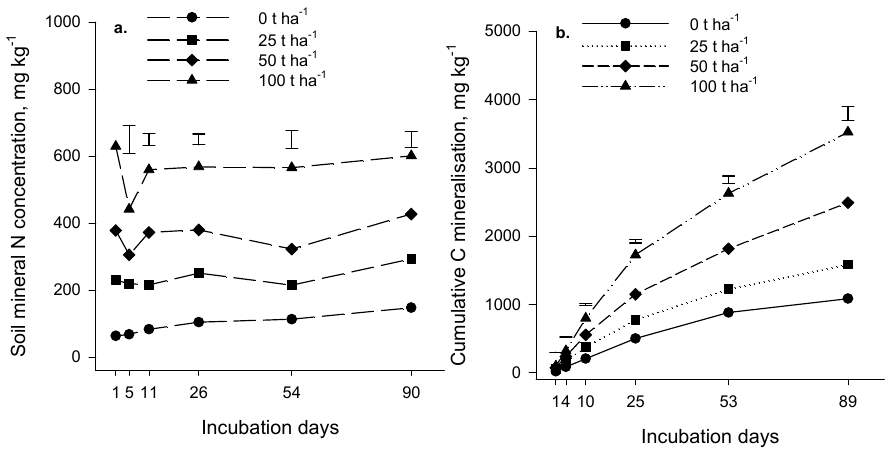
Figure 1. Forage trial incubation: (a) soil mineral N concentration and (b) cumulative carbon mineralization during a 90-day incubation with and without added compost. Bars represent 5% LSD with 24 df .